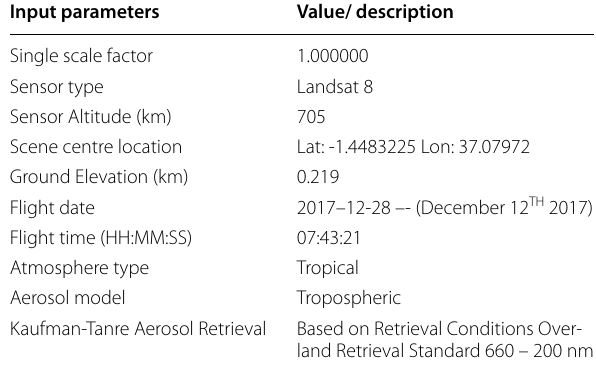
Table 4 Landsat 8 OLI parameters from metadata